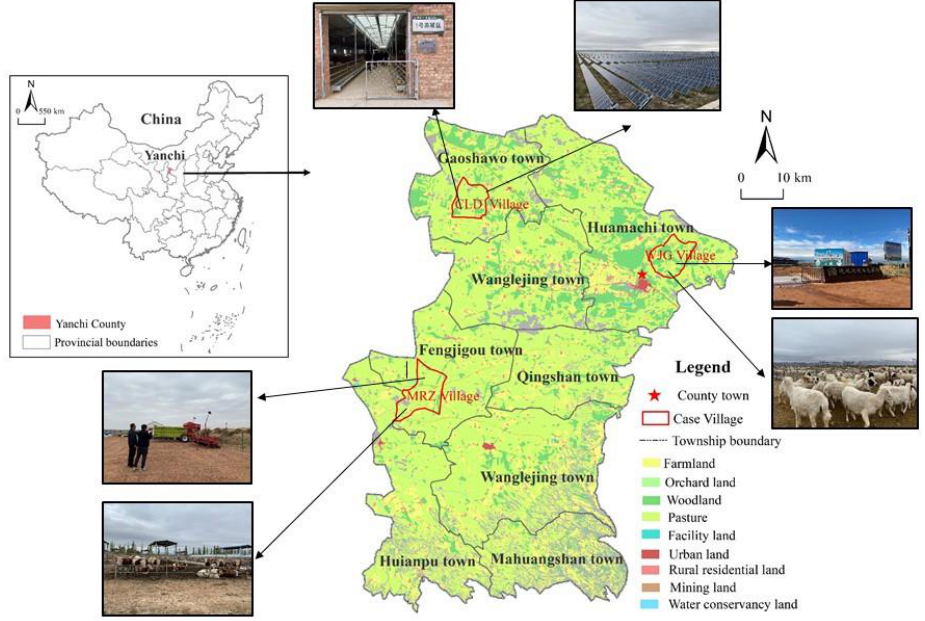
Figure 3. Location of Yanchi County and its land